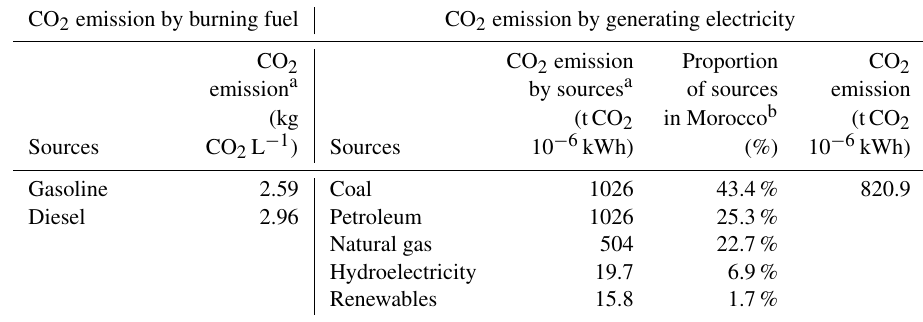
Table 2. CO 2 emission by burning fuels and generating electricity.